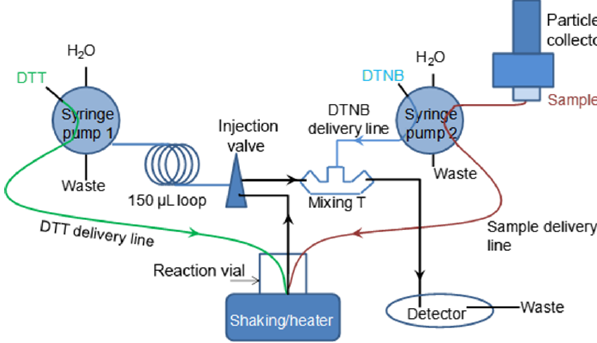
Figure 1. Flow diagram for the online monitor of the oxidative ca- pacity of aerosols